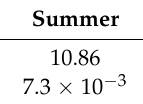
Figure 4. Wave roses showing direction-oriented spatial distribution of average ( a ) extreme annual Tm ( b ) extreme winter Tm ( c ) extreme summer Tm ( d ) timeseries of Tm between 1979 – 2005. Table 3. Average extreme Tm and its trends between 1979 – 2005.